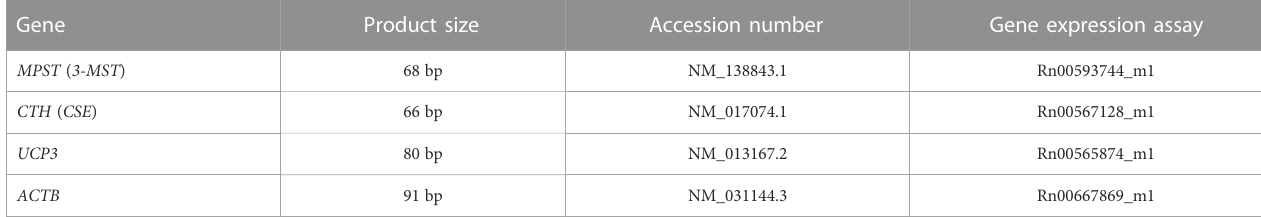
TABLE 1 Gene Expression Assay that were used to determine gene expression.